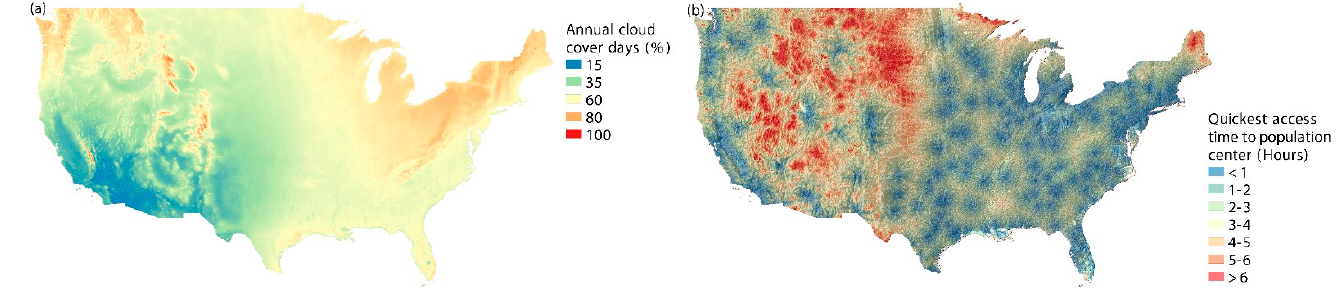
Figure 2. Datasets used to model potential for remote sensing in watershed monitoring: ( a ) mean annual fraction of cloudy days, and ( b ) maximum shortest travel time to population center within each HUC-12 subwatershed. These quantities are surrogates for acquisition and accessibility of remotely sensed scenes and in-situ data needed to ground-truth them.